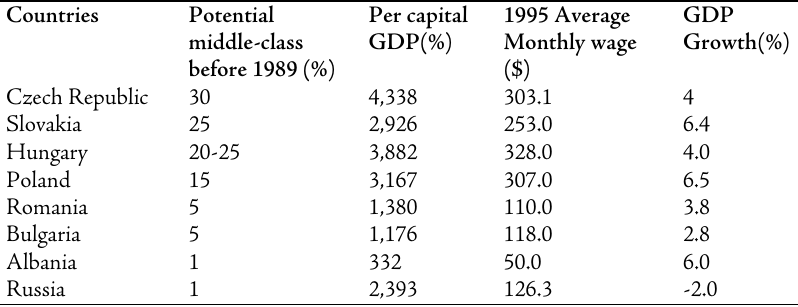
Table 1 – Transition in Post-Communist